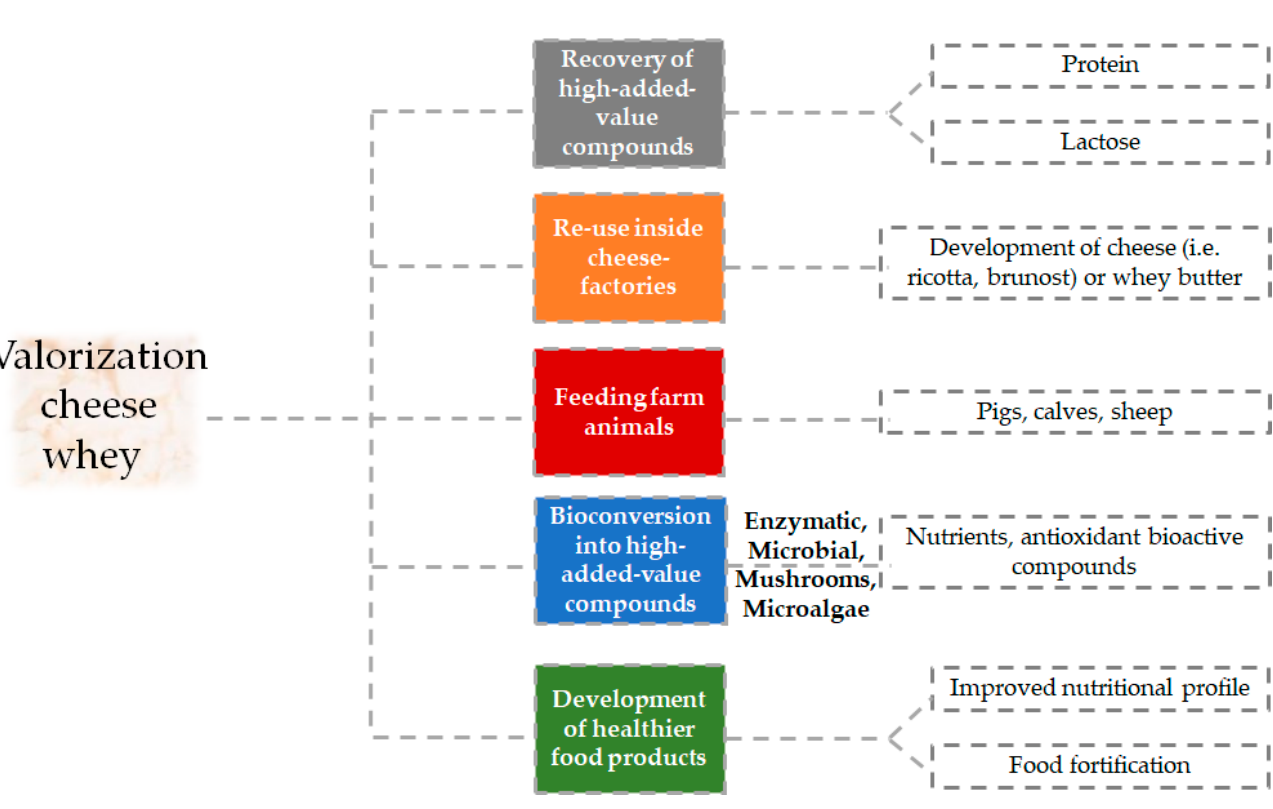
Figure 1. Conventional and emerging applications of cheese whey.